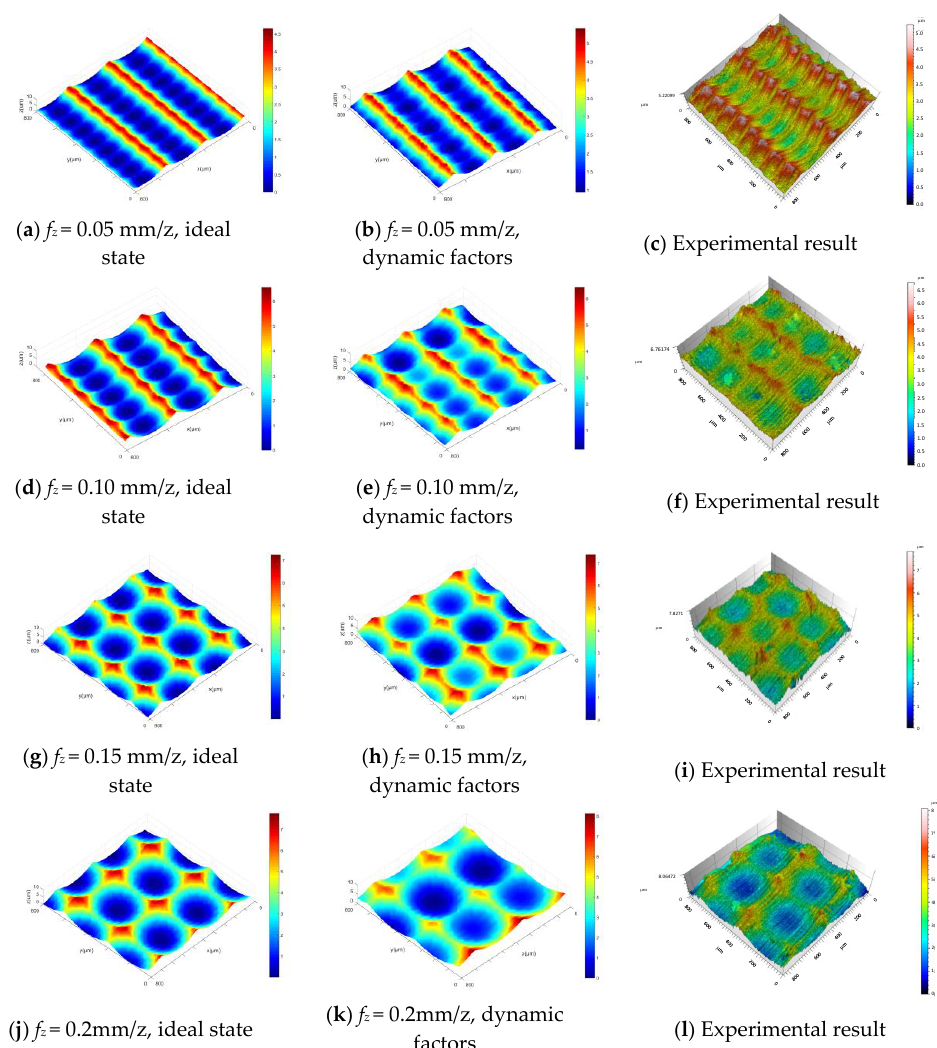
Figure 16. Surface topography simulation considering dynamic factors.